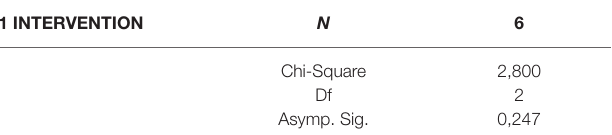
TABLE 6 | Test statistics.